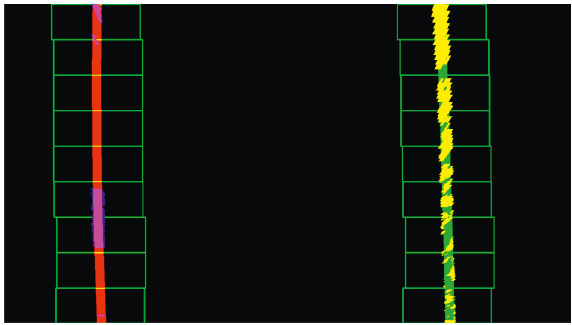
Figure 13: Result of linear